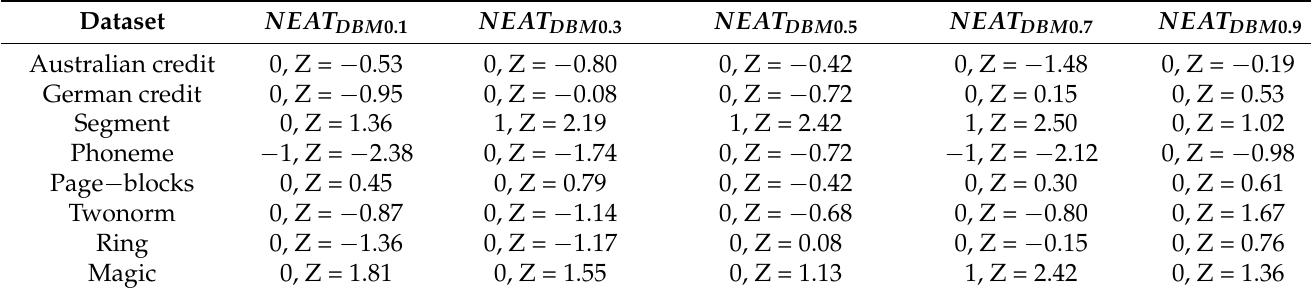
Table 5. Mann–Whitney statistical tests of NEAT-DBM compared to NEAT, training set.